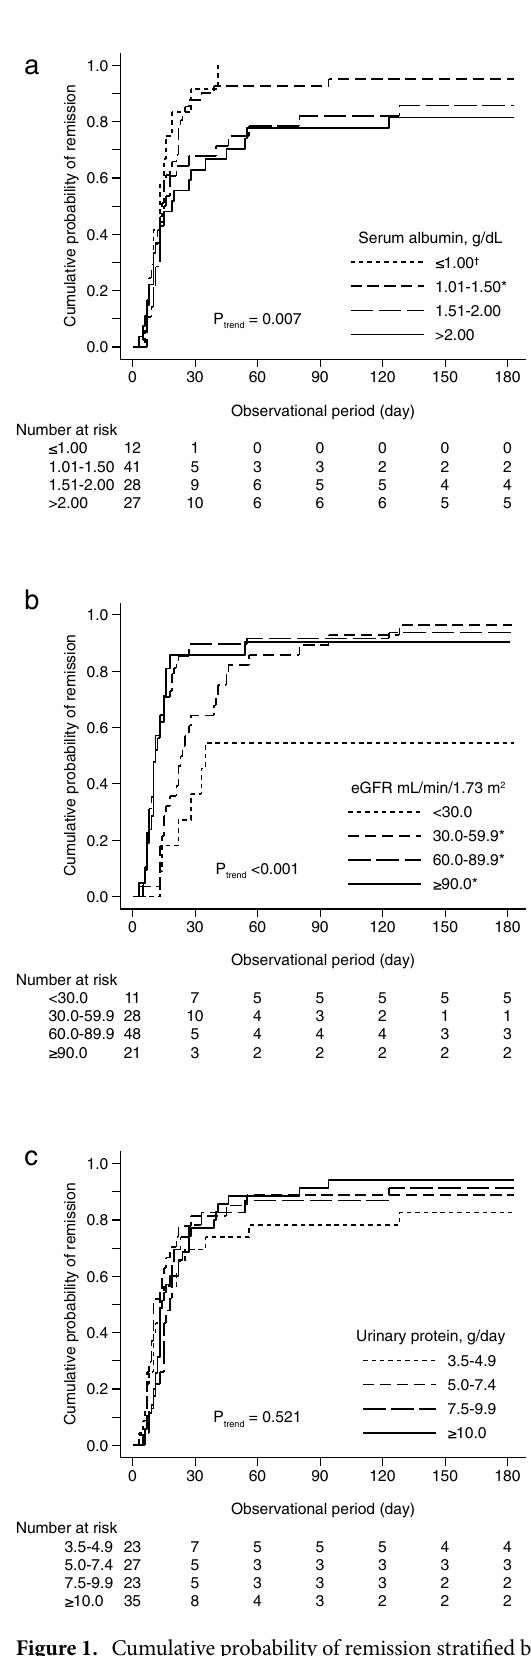
Figure 1. Cumulative probability of remission stratified by serum albumin concentration ( a ), eGFR level ( b ), and urinary protein level ( c ). *P < 0.05, vs. serum albumin concentration > 2.00 g/dL and eGFR < 30.0 mL/ min/1.73 m 2 . † P < 0.10, vs. serum albumin concentration > 2.00